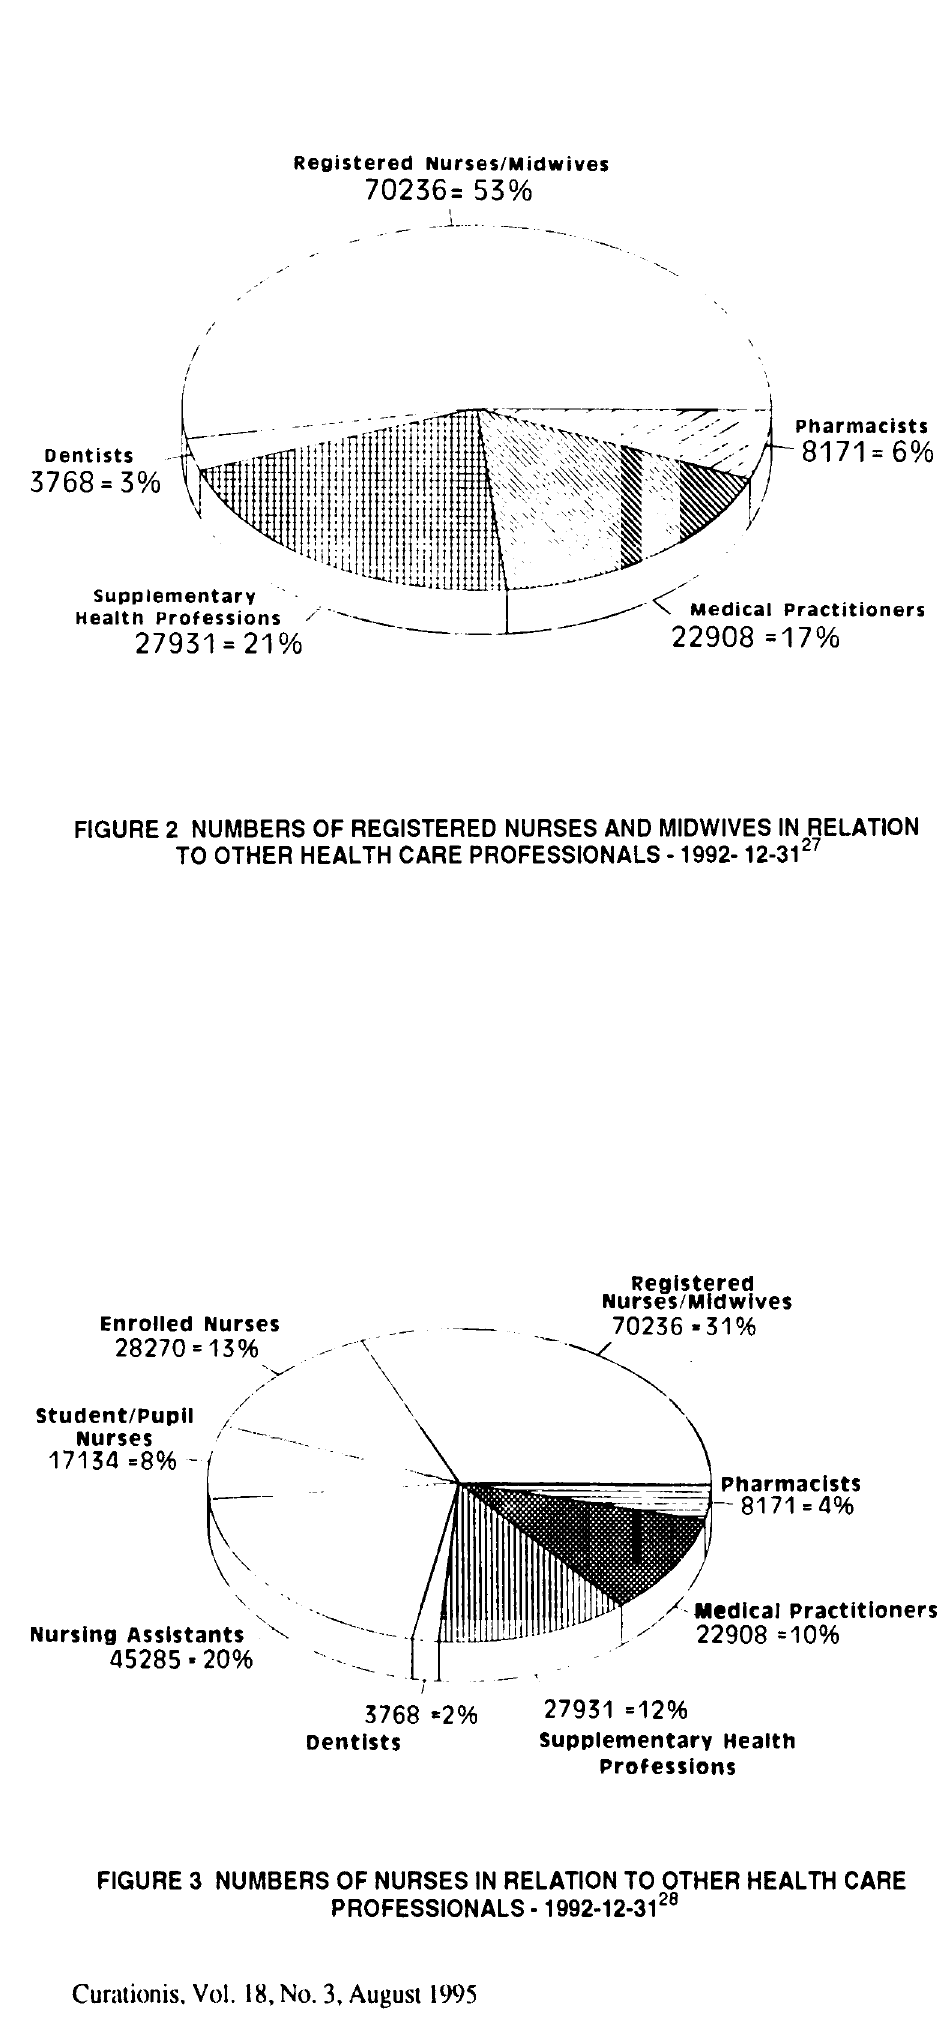
FIGURE 3 NUMBERS OF NURSES IN RELATION TO OTHER HEALTH CARE PROFESSIONALS ■ 1992-12-31